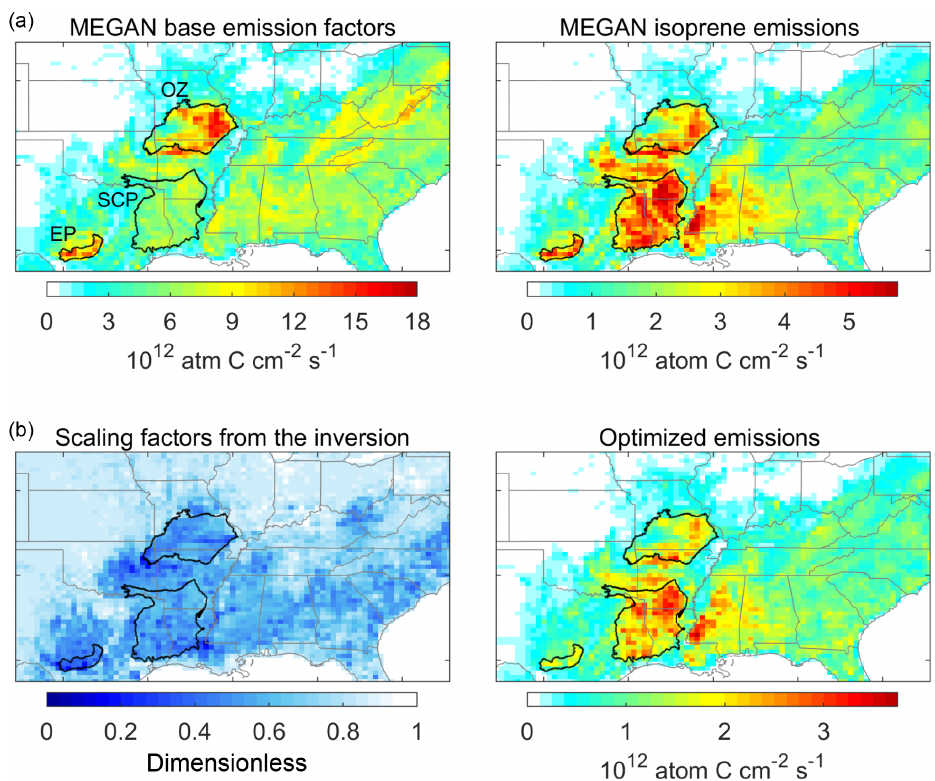
Figure 2. Isoprene emissions in the southeast US. (a) MEGAN v2.1 base isoprene emission factors and emissions for the SEAC 4 RS time period. (b) Scaling factors from the inversion and optimized emissions. The color scale differs for MEGAN and optimized emissions. The Edwards Plateau (EP), Ozarks (OZ), and South Central Plains (SCP) ecoregions are denoted by black